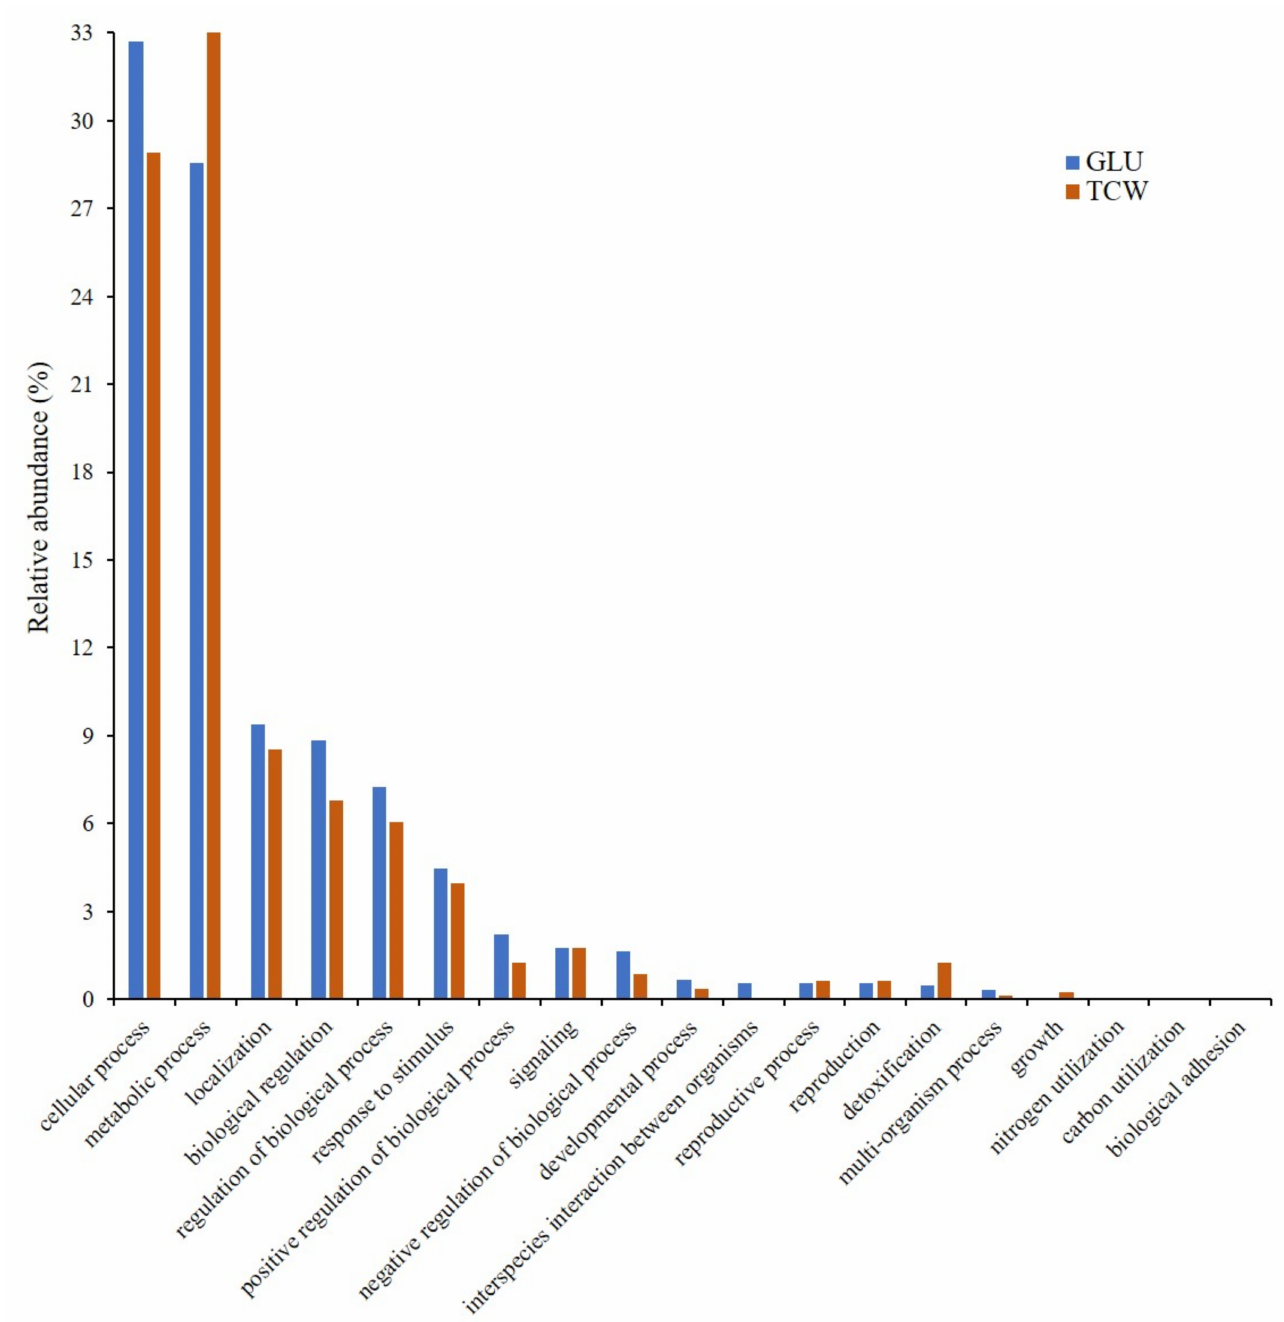
Figure 2. Gene ontology (GO) classification by the biological process (level 2 of categorization) of proteins, exclusively identified or overexpressed in B. cinerea proteomes (membranome, phosphoproteome, phosphomembranome, and se- cretome), under GLU and TCW conditions, as the sole carbon source. Relative abundance represents the percentage of membrane-associated phosphoproteins identified in each category relative to the total number of protein GO annotations in this